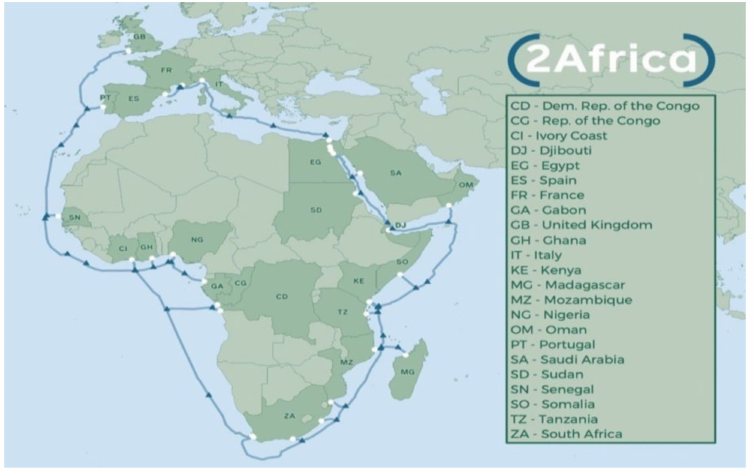
Figure 11. 2Africa submarine cable system